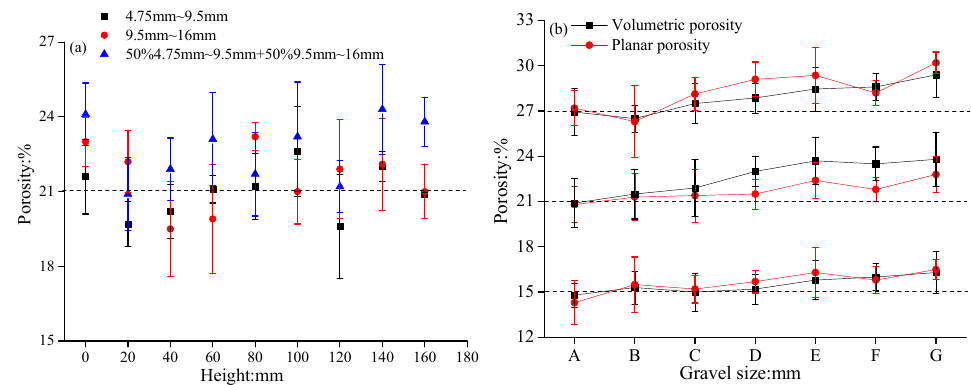
Figure 5. Porosity of pervious concrete. ( a ) Planar porosity, the design porosity was 21%; ( b ) volumetric porosity and average planar porosity, the design porosity was 15%, 21%, and 27%. The figure shows an average value and standard deviation of three to five specimens.